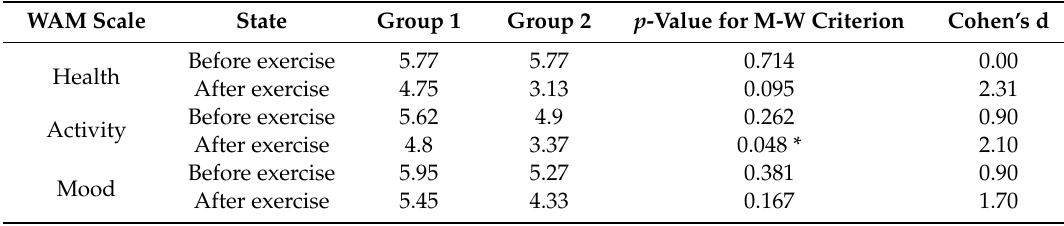
Table 2. Scores of Well-being, Activity, Mood (WAM) questionnaire in group 1 and group 2 before and after exercises.